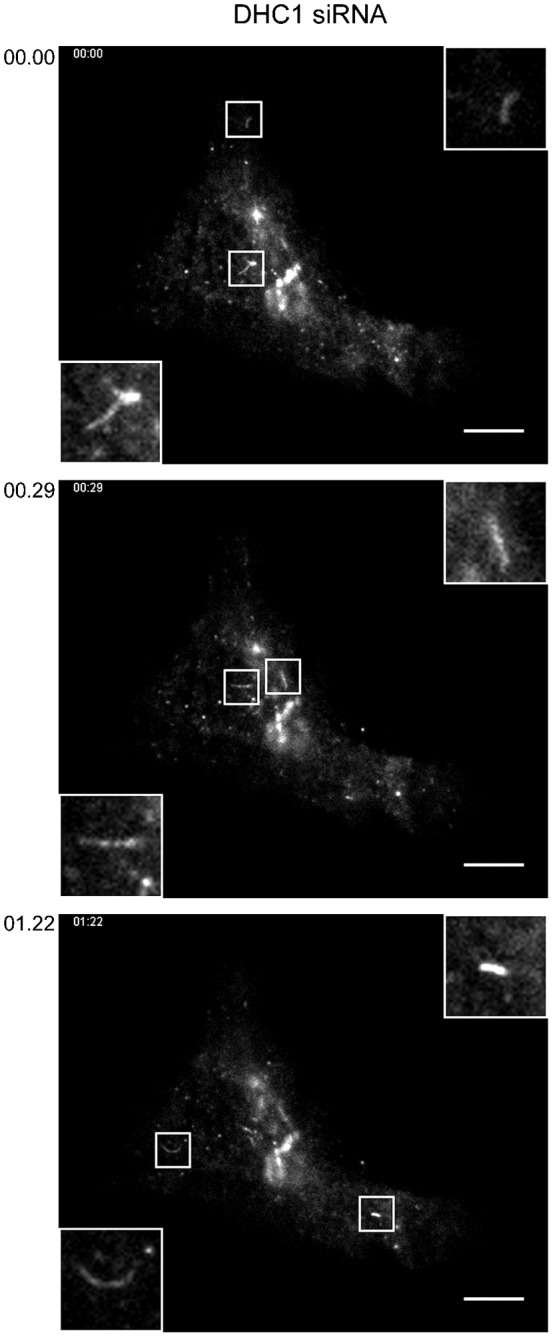
Increased tubulation of ER-to-Golgi carriers following suppression of DHC1 expression.Examples are taken from the time lapse movie sequence associated with Fig. 1D. Boxed regions show 3× enlargements. Time from the start of the image sequence is shown (mins:secs). Scale bars: 10 µm.